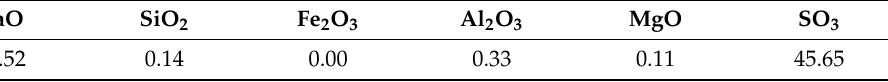
Table 2. Chemical composition of gypsum/wt%.